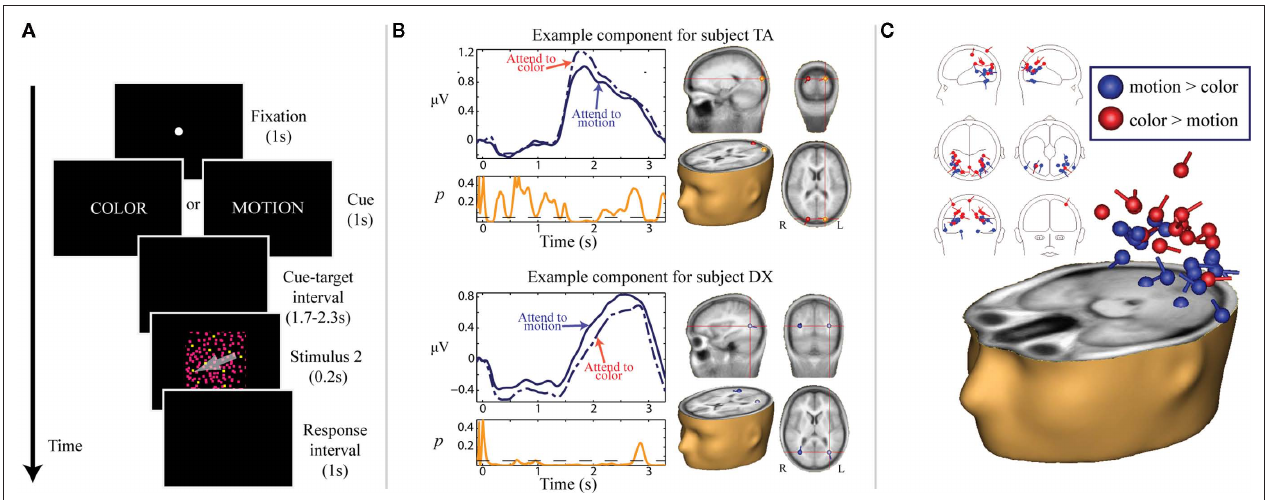
cued (“feature-sensitive”). TSE waveforms illustrating this effect are depicted in violet for two representative subjects. The solid lines represent attention to motion and the dashed/dotted lines represent attention to color. Below the TSE waveforms, running p -values for the alpha power difference between the two attention conditions is plotted in orange. To the right of the TSE waveforms, point-equivalent dipole source estimates for the corresponding components are depicted in a standard MNI brain volume. (C) Localization of all feature-sensitive alpha-reactive components across participants. Components are color-coded according to the direction of feature-sensitivity: components with greater alpha power for attention to color than for attention to motion are plotted in red, and components with greater alpha power for attention to motion than for attention to color are plotted in blue. The distributions of the estimated sources for two types of components are significantly different. Components with higher alpha power for attention to color are generally localized to putative dorsal visual stream regions, whereas components with higher alpha power for attention to motion are generally localized to putative ventral visual stream regions. This pattern of results is consistent with a suppressive role of anticipatory alpha-band